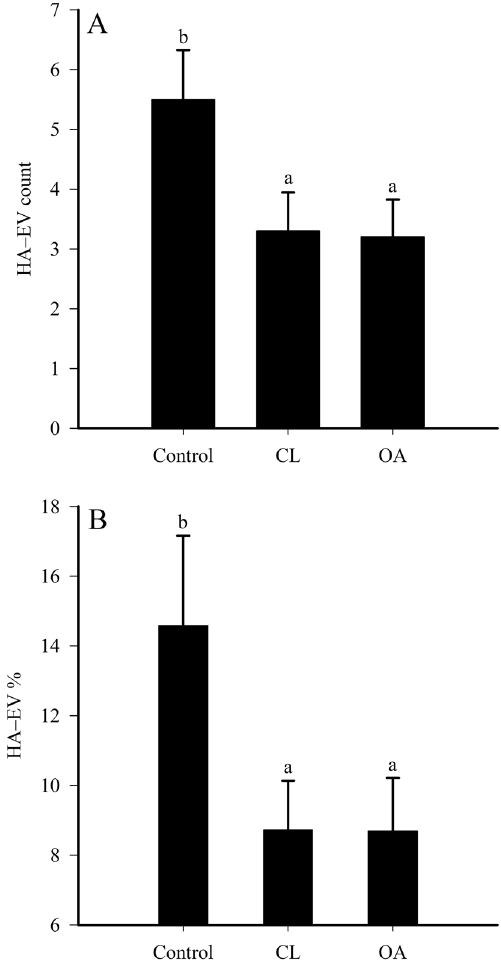
Figure 4. Count ( A ) and % ( B ) of hyaluronan-containing extracellular vesicles (HA–EVs) in equine synovial fluids. The samples were collected from control, contralateral (CL), and osteoarthritic (OA) fetlock joints (means + SE). HA–EV % represents the proportion of EVs with HA staining of the total EV count on the visual fields. Bars with dissimilar lowercase letters differ significantly from each other (generalized linear model, p <